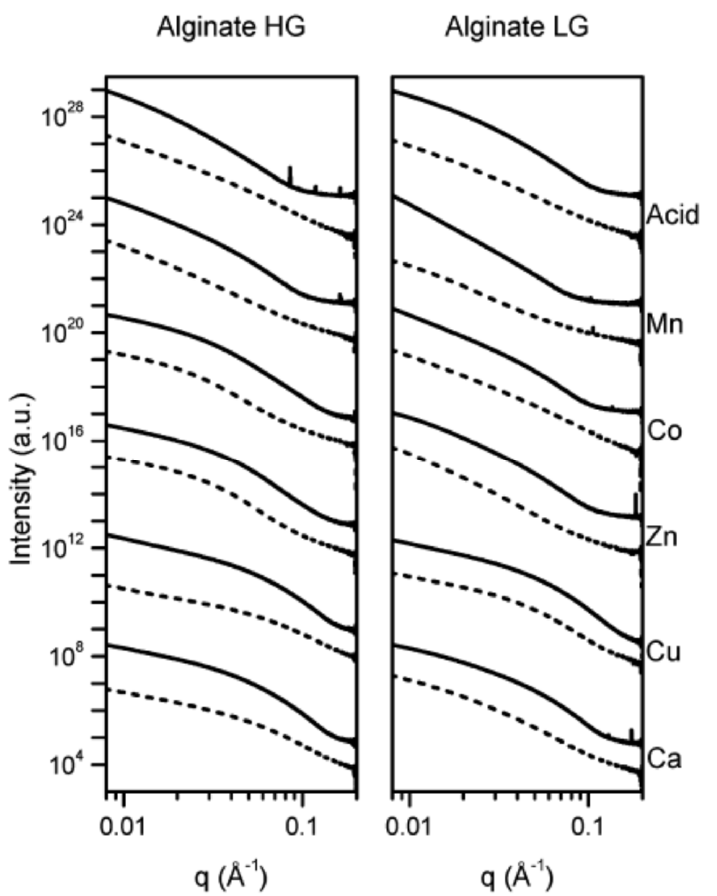
Figure 7. SAX profiles for aerogels (solid lines) and hydrogels (dashed lines) obtained from alginates with high G (HG) or high M/low G (LG) units’ content. Reprinted with permission from [233] (Copyright 2012, American Chemical Society).